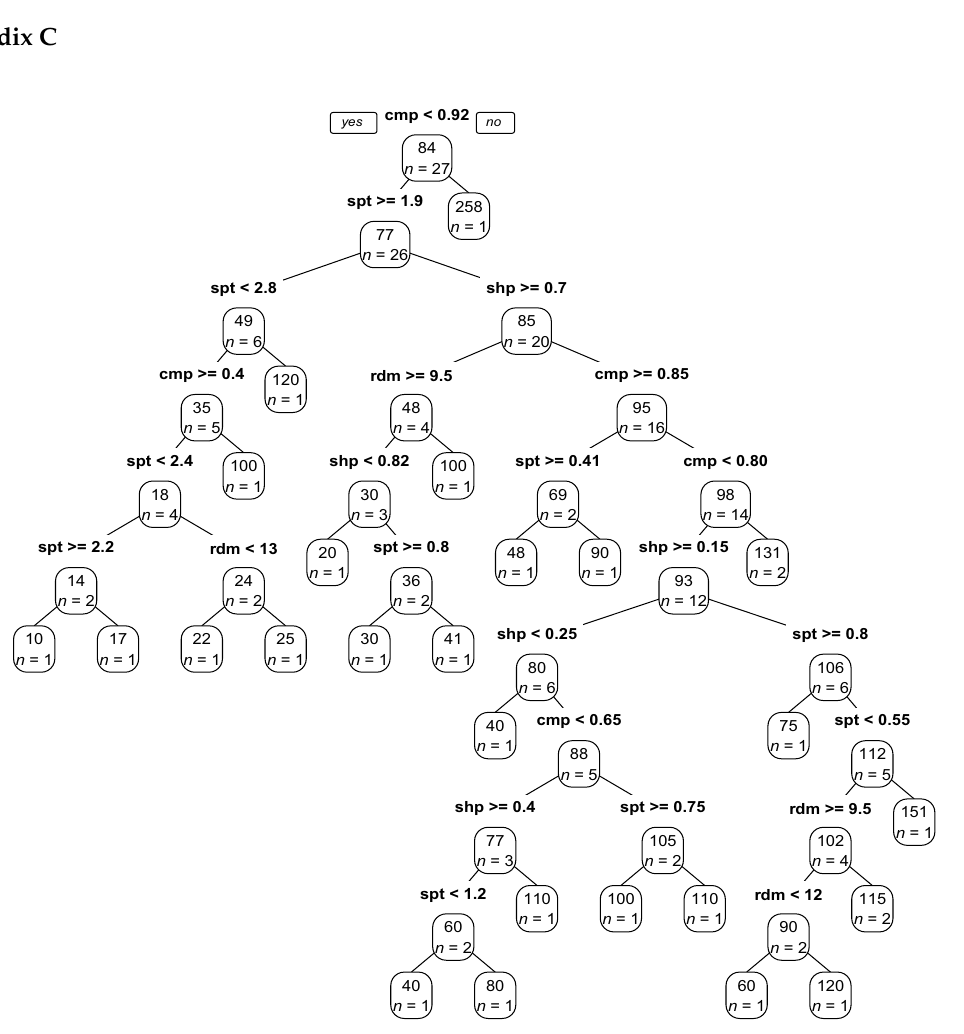
Figure A3. Graphical representation of the rulesets of the RT model established for the building class. Note: spt = spatial resolution, rdm = radiometric resolution, shp = shape/color weight, and cmp = compactness/smoothness weight, n = the number of samples at each node; the values in the rectangles are the estimated SPs.